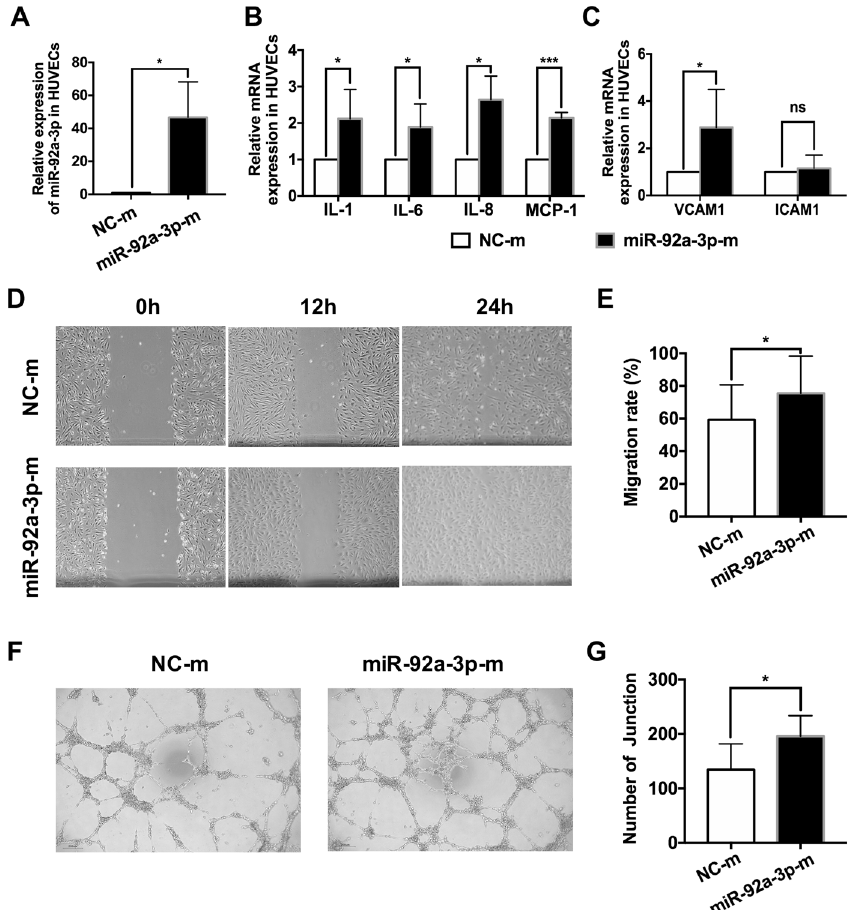
Fig. 6 Overexpression of miR-92a-3p in HUVECs enhances angiogenesis in vitro. A , B HUVECs were transfected with synthetic mimic control (NC-m) or miR-92a-3p mimic (miR-92a-3p-m). The mRNA levels of miR-92a-3p, VCAM1, ICAM1, IL-1, IL-6, IL-8, and MCP-1 were increased ( n ≥ 4, * P < 0.05, ** P < 0.01, *** P < 0.001). C Wound-healing assay revealed that miR-92a-3p could enhance the migration rate of the HUVECs. D Relative quanti fi cation of HUVEC migration 24 h after the wound scratch ( n = 4, * P < 0.05). E , F Quantitative evaluation of the number of junctions after transfection of the HUVECs with NC-m or miR-92a-3p (24 h, n = 9, * P <